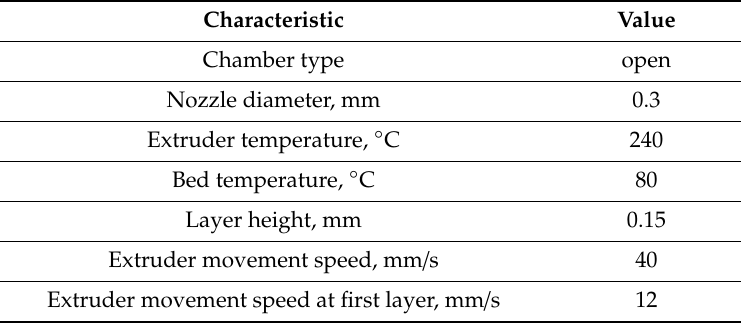
Table 1. Properties of NYLON material.